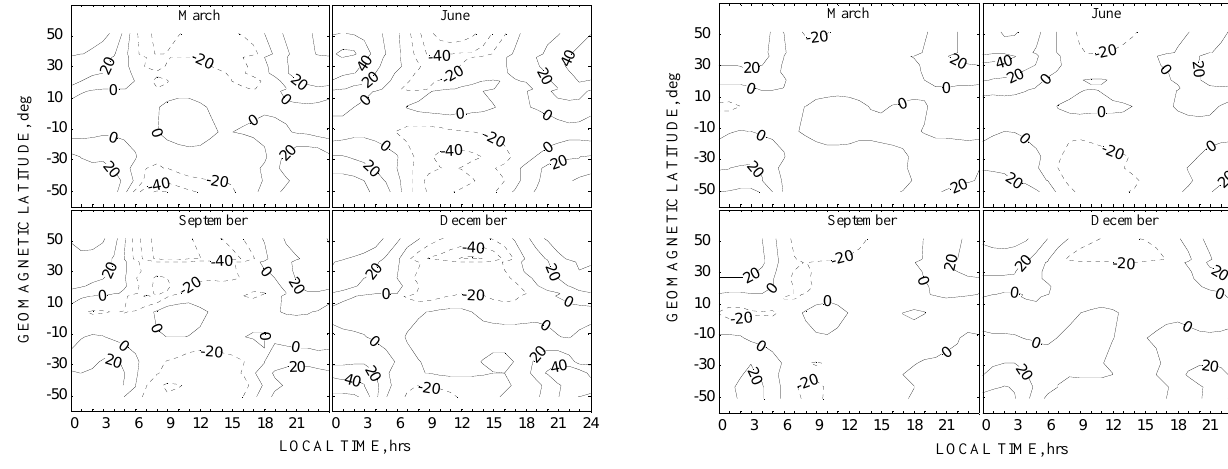
Fig. 2. Same as Fig. 1, but for solar maximum. itudes are similar at both hemispheres, and that the magnetic meridional winds can lead to significant differences between two hemispheres. The flow from summer to winter hemi- sphere is just an equatorward flow at the summer hemisphere and a poleward one at the winter hemisphere, which con- tributes to the upward and downward VEWs, respectively. Secondly, at latitudes higher than about 30 ◦ the day- time VEWs are always larger in magnitudes in the North- ern Hemisphere than the Southern Hemisphere, except dur- ing the March equinox, and at latitudes between about 10 ◦ and 30 ◦ , the northern daytime VEWs magnitudes are